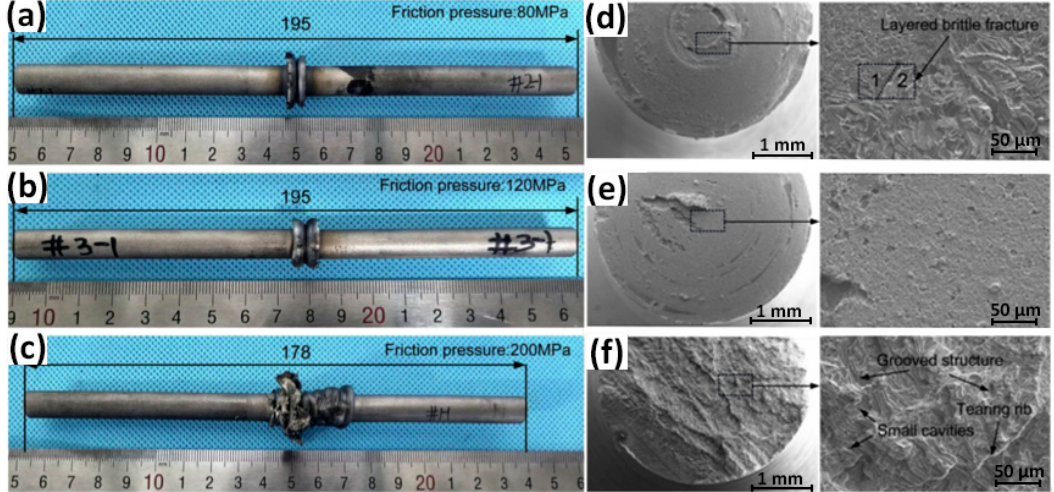
Figure 11. Morphology of the welds and fractured surfaces after tensile testing. The joints were obtained under the friction pressures of: ( a ) and ( d ) 80 MPa; ( b ) and ( e ) 120 MPa; ( c ) and ( f ) 200 MPa (Adapted from [91], with permission from Elsevier, 2020).